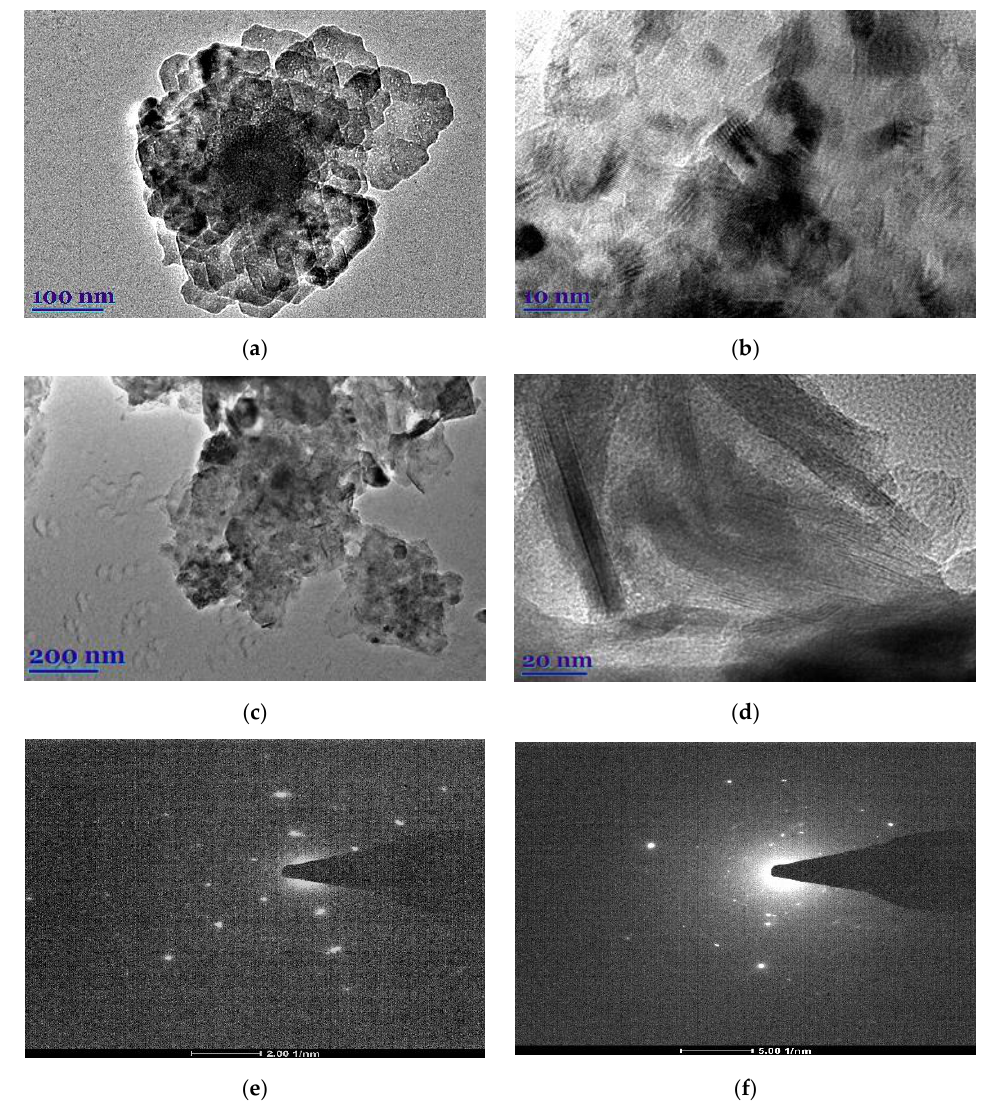
Figure 1. TEM images ( a – d ) and SAED ( e , f ) of E. globulus ( a , b , e ) and S. officinalis ( c , d , f )